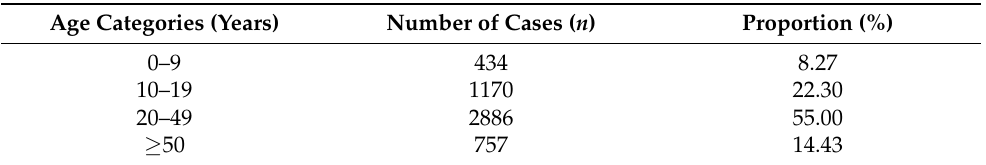
Table 1. Proportion of affected dengue cases by age categories during the dengue epidemic in 2019, Bhutan (note: 688 records do not have information on age).